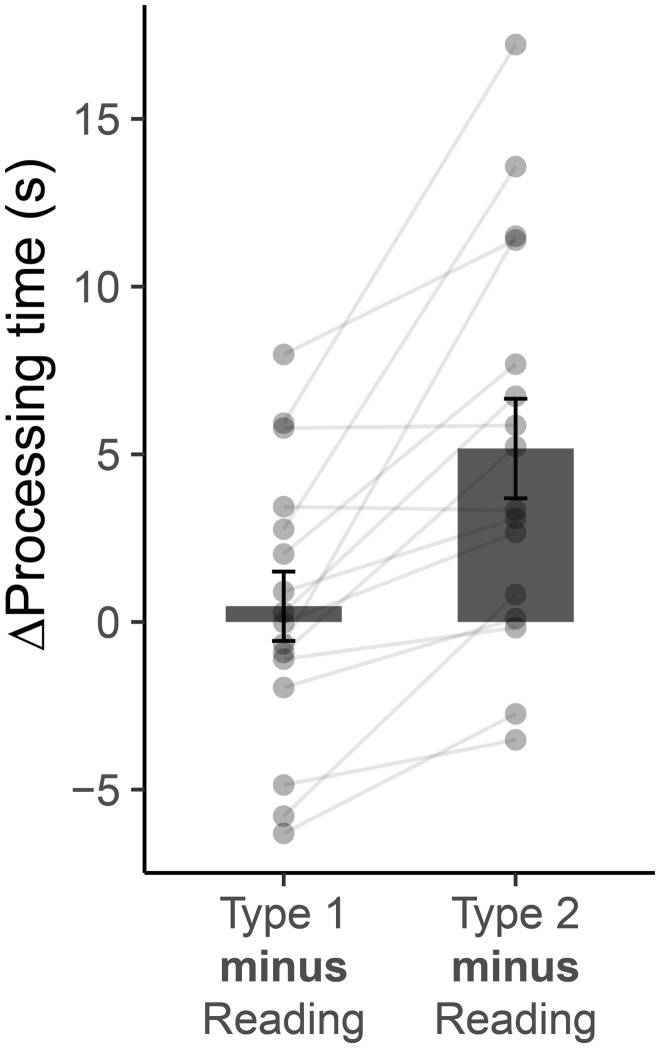

Behavioural results. Bar graphs represent the difference between the response time of diagnosing cases (Type 1 and Type 2) and reading cloze probability sentences. Error bar reflects mean ± SEM.